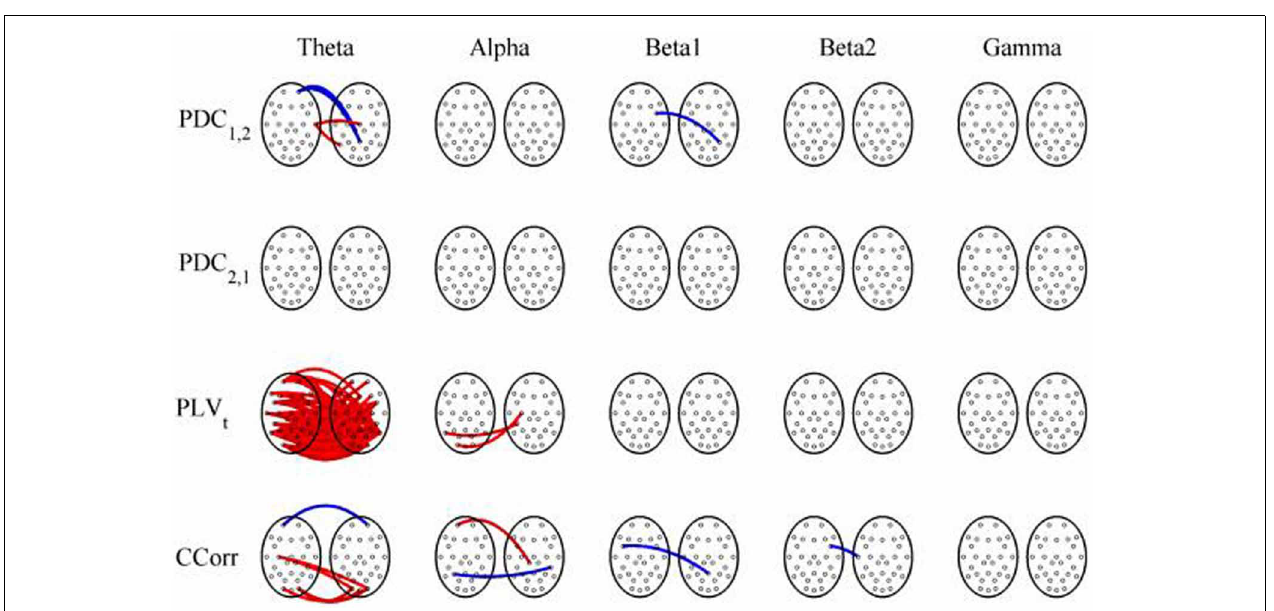
FIGURE 8 | Significant changes in mean time-averaged hyperconnectivity between pre- and post-stimulus conditions by connectivity measure and frequency band. The rows represent the hyperconnectivity results for each of the measures used (PDC 1 , 2 , PDC 2 , 1 , PLV t and CCorr) and the columns represent the frequency bands (theta, alpha, beta1, beta2, and gamma). The pairs of large circles in each cell represent the heads of the participants in a pseudo-pair. The smaller circles indicate the topographical location of the EEG recording electrodes. For PLV t and CCorr, lines drawn between the heads joining electrode sites indicate